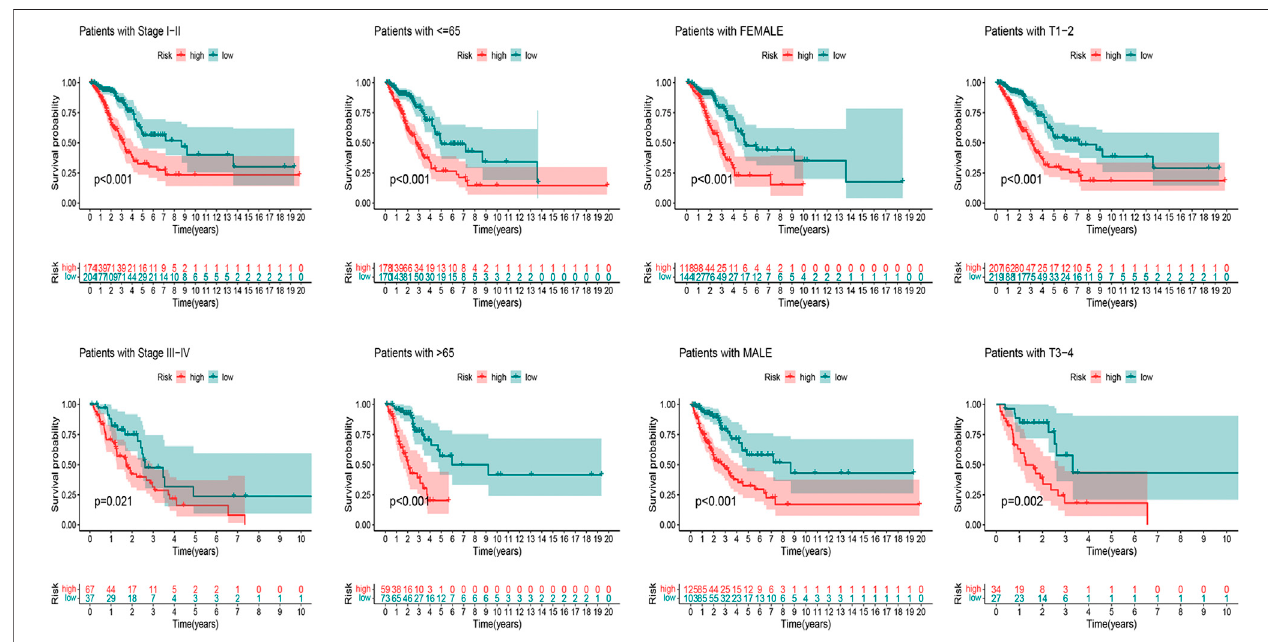
FIGURE 7 | Kaplan – Meier curves of OS difference strati fi ed by LUAD stage (I – II or III – IV), age ( ≤ 65 or > 65), gender (female or male), and TNM stage (T1 – 2 or T3 – 4) between high-risk and low-risk groups in TCGA entire set.